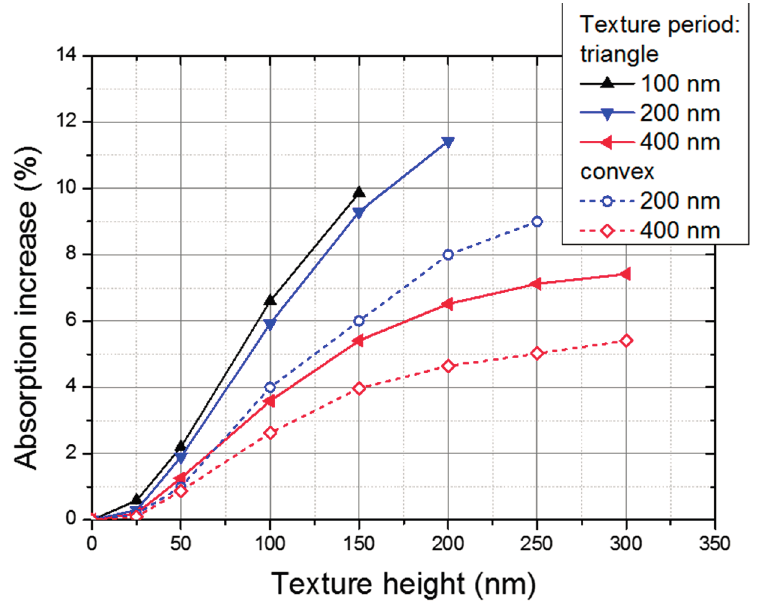
Figure 6. Absorption enhancement in CIGS absorber layer with reference to the flat, non-structured